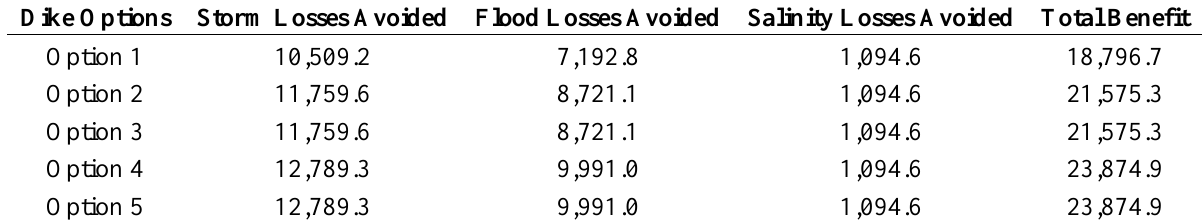
Table 6. Present values of the benefits of the different dike options (discount rate = 3%, units: million USD).